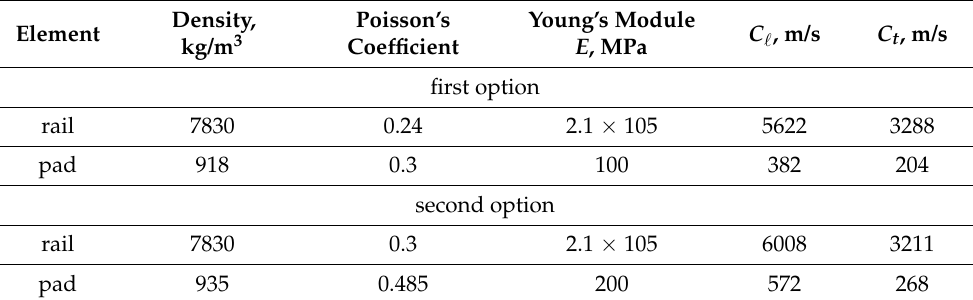
Table 1. Physical-mechanical characteristics the contact pair of the rail-pad.